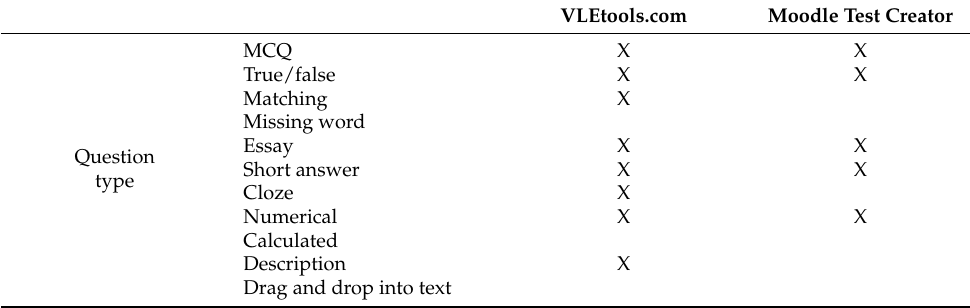
Table 1. Comparison of the features of Web-based plugins.